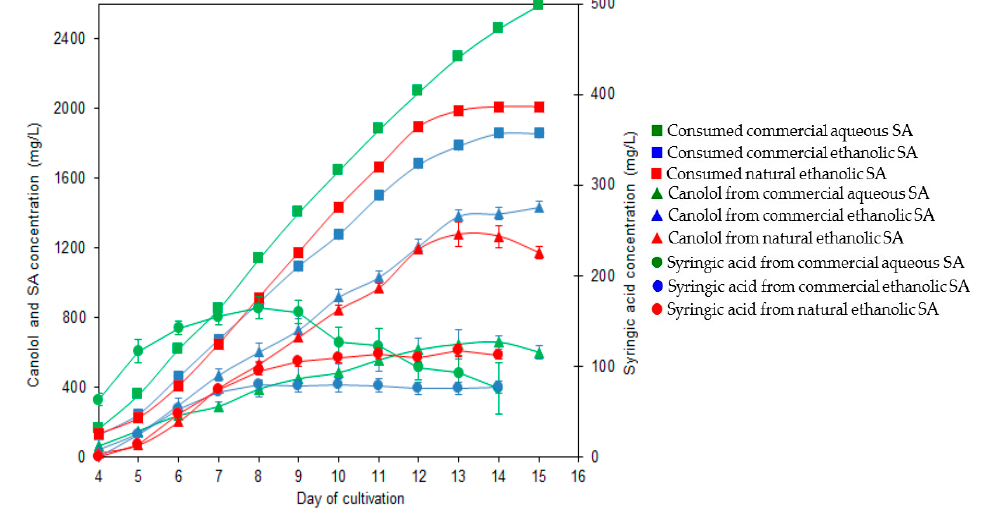
Figure 5. Comparison of SA metabolism by N. lepideus BRFM15 supplemented with different sources of SA. Cultivations were carried out in the presence of aqueous commercial SA (green symbols), ethanolic commercial SA (blue symbols), and natural ethanolic SA from RSM (red symbols). Consumption of SA in relation to the production of canolol and syringic acid.